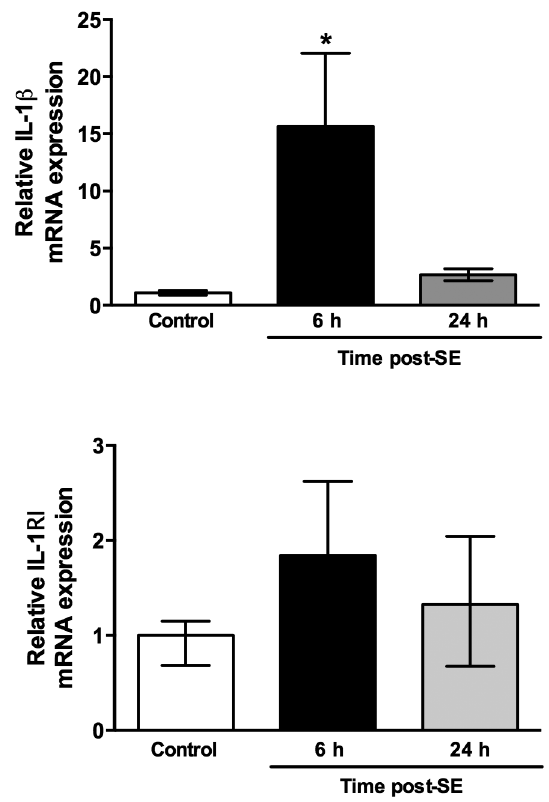
Figure 1 - Relative Interleukine-1 β (IL-1 β ) and type 1 IL-1 receptor (IL-1RI) mRNA expression in hippocampus under control conditions and 6 and 24 h after status epilepticus (SE). Data are shown as the mean ± S.E.M. and were analysed by a One-way ANOVA followed by a Tukey test. *p<0.05 vs control and 24 h following